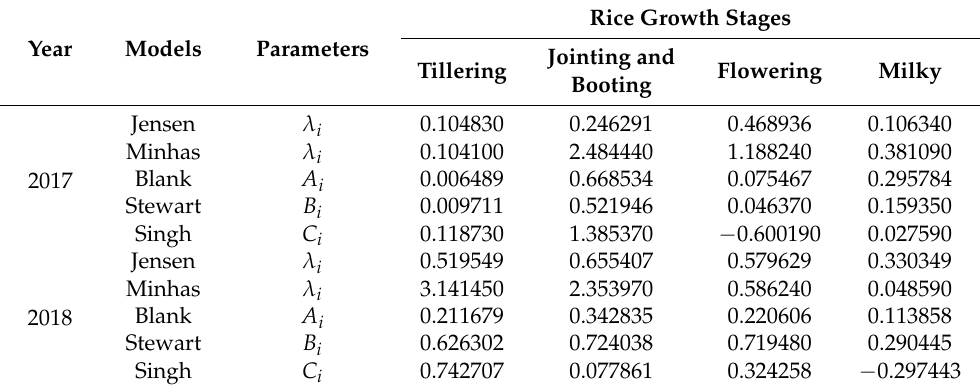
Table 4. Sensitivity index of each model in 2017 and 2018.